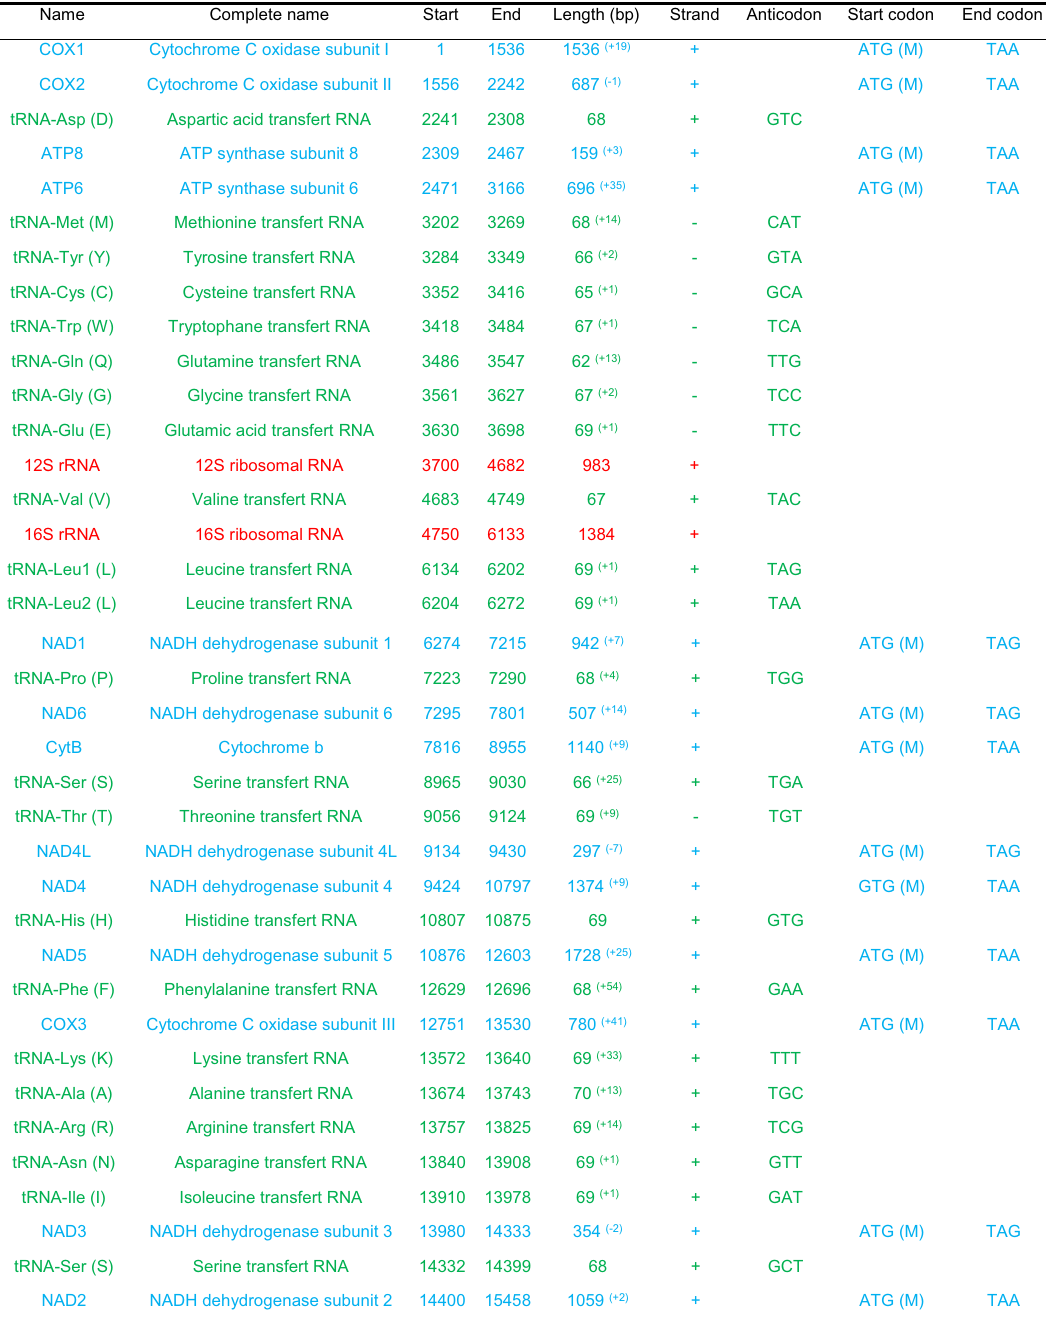
Table 1. Mitogenome profile of A. gigas . The 13 Protein coding genes (PCGs) in blue, the 22 transfer RNA (tRNA) in green, and the two ribosomal RNA (rRNA) in red. All tRNAs have the three and one letter code, numbers in brackets in length column represent the number of nucleotides separating two genes (+) or overlapping two genes (−) downstream from the gene where it is